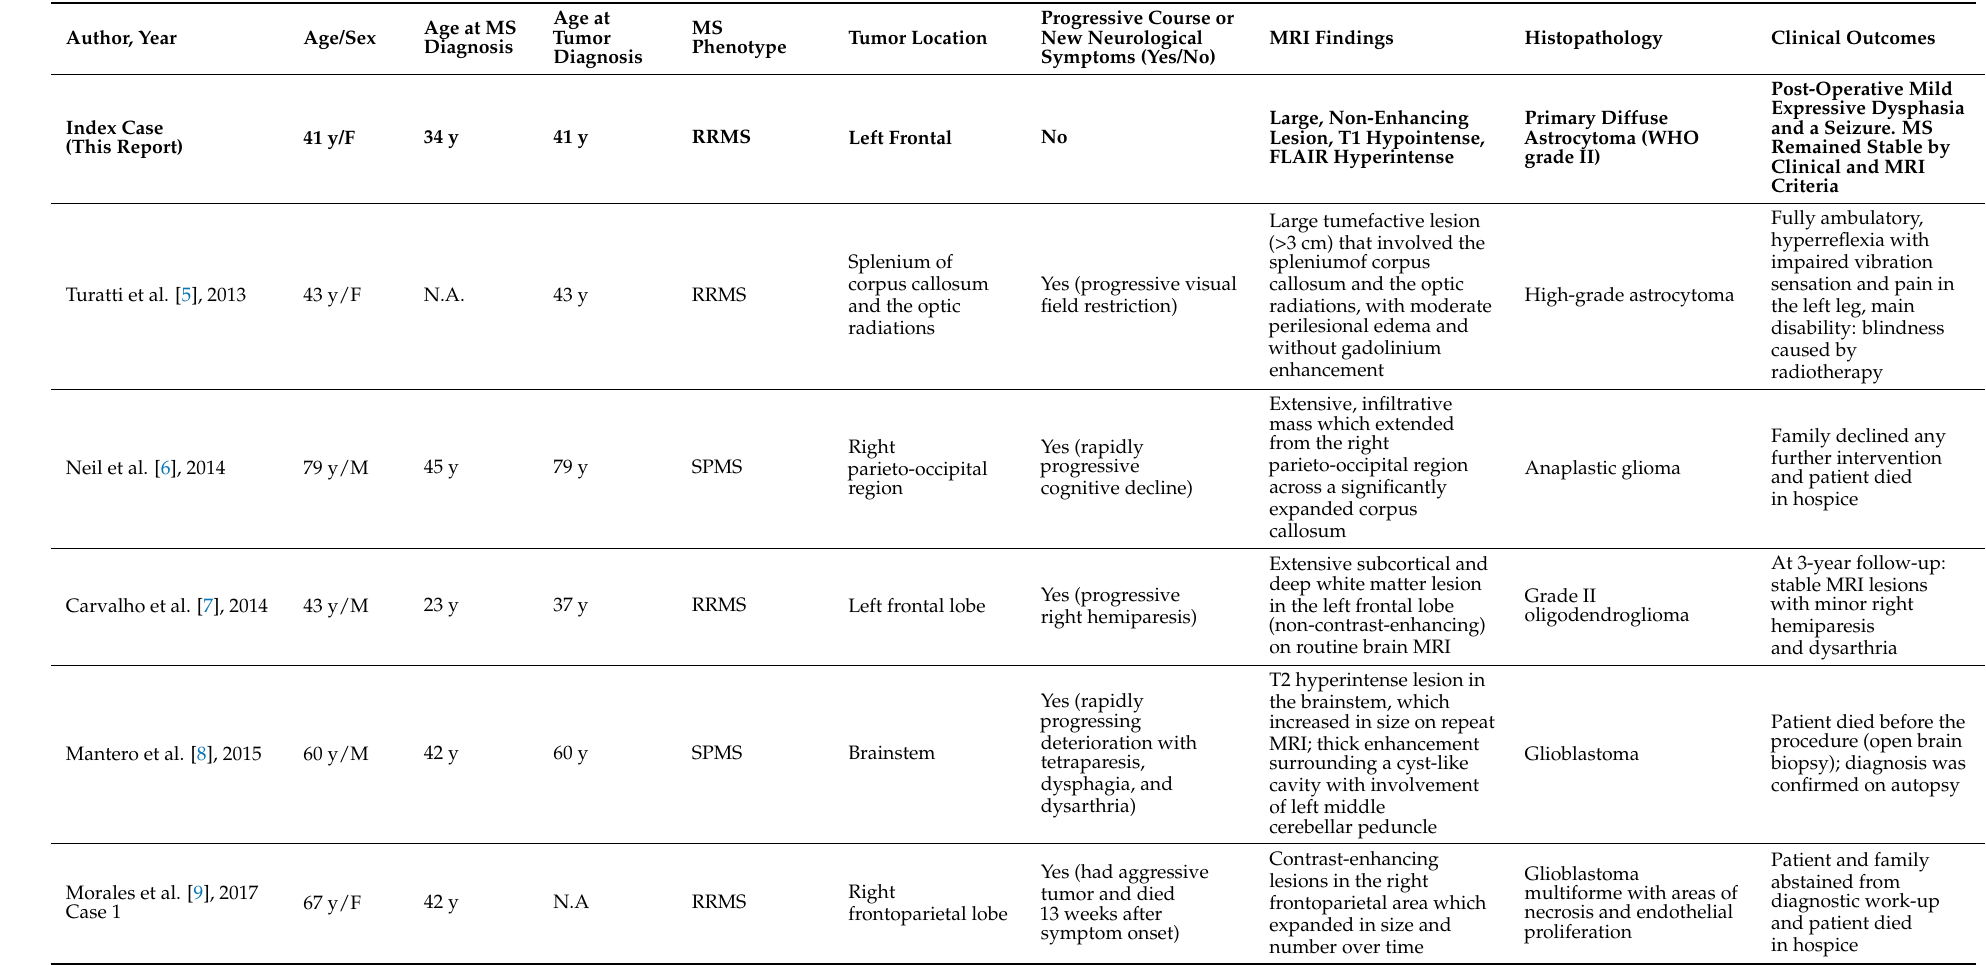
Table 1. Topical review of recently reported cases of gliomas in MS